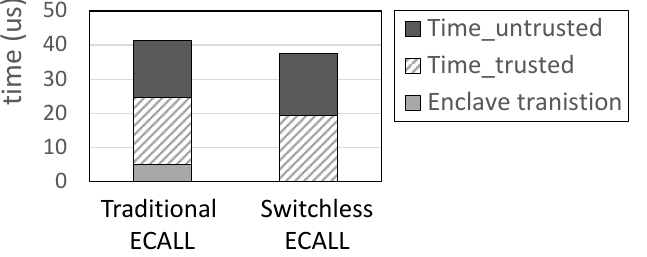
Figure 5. The comparison of CPU time breakdown between an ECALL and a switchless